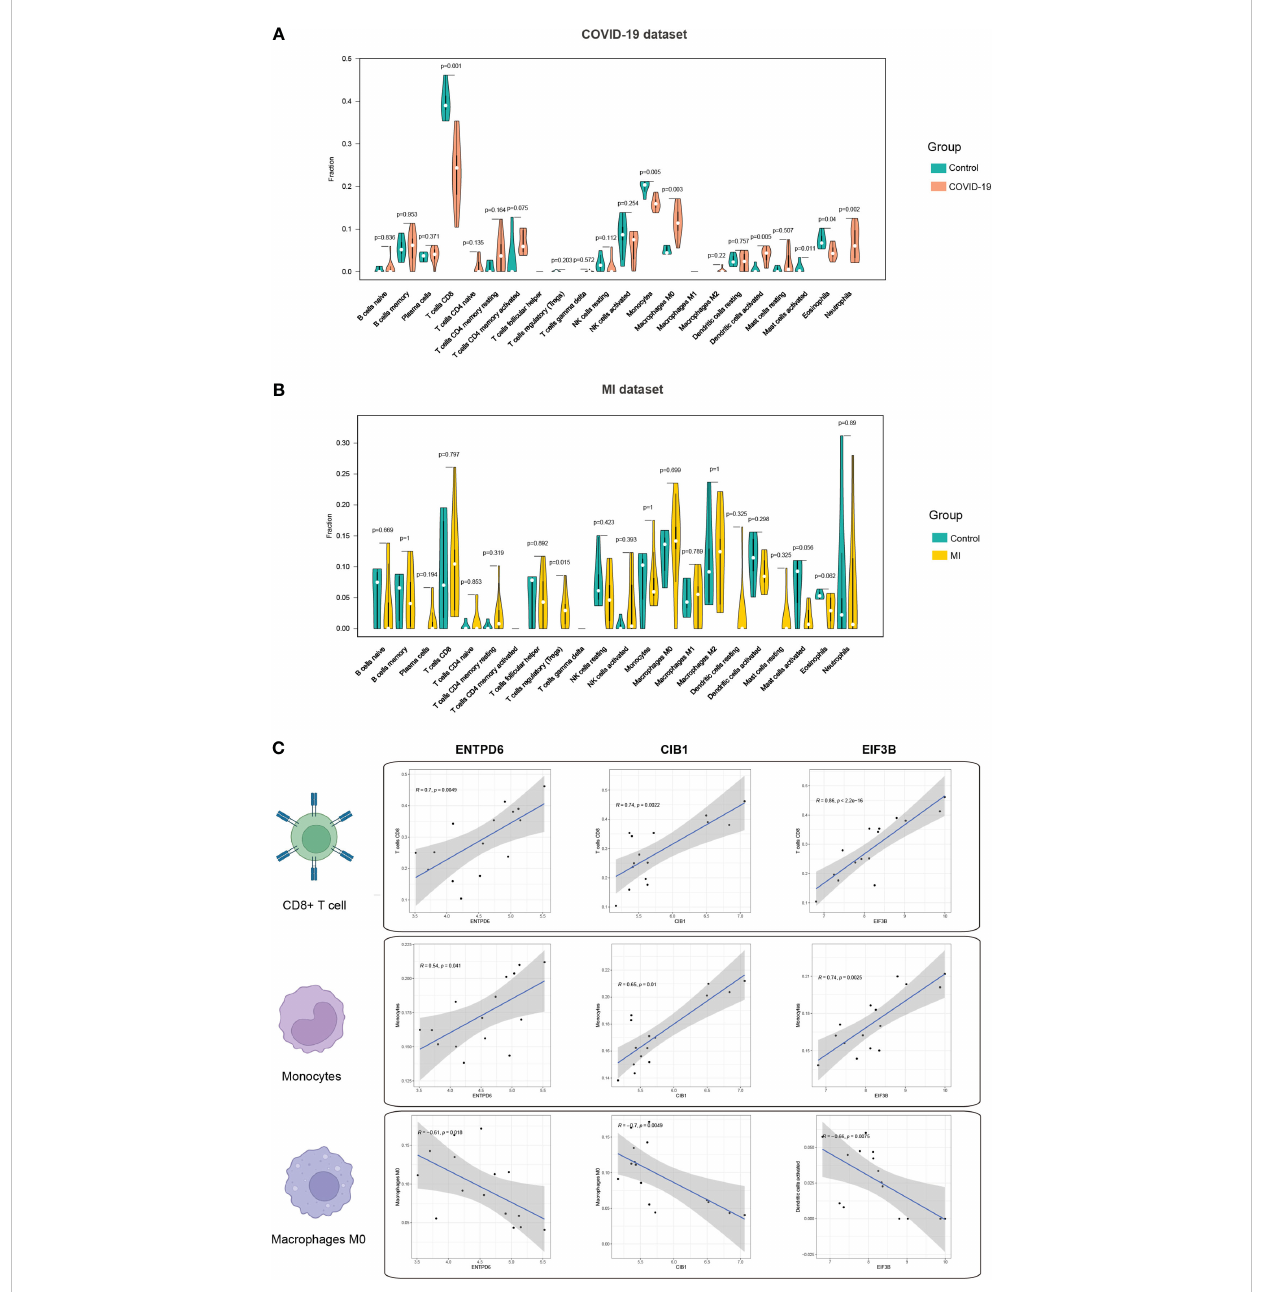
FIGURE 7 Immune in fi ltration pro fi le of three hub CORGs. (A) Violin plot depicts signi fi cant multiple immune cells between the COVID-19 and control groups. (B) Violin plot depicts signi fi cant multiple immune cells between the MI and control groups. (C) Correlation analysis of hub CORGs (ENTPD6, CIB1, and EIF3B) and signi fi cant immune cells (CD8+ T cell, monocyte, and macrophages M0). CORGs, COVID-19-related differentially expressed genes; MI, male